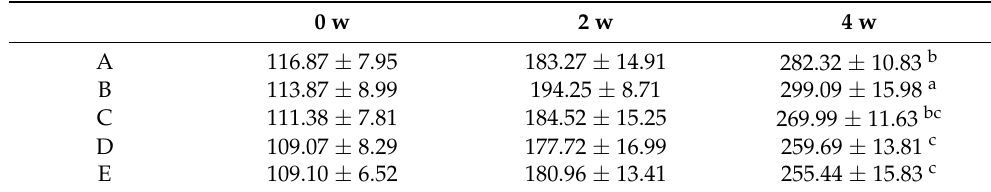
Table 1. Effects of different GSP groups on weight of rats (g).